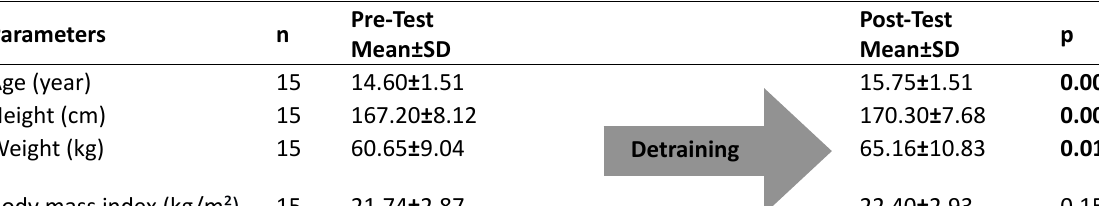
Table 1. Anthropometric Characteristics of the Fencers